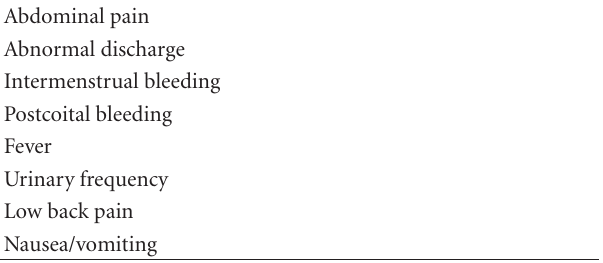
Table 1: Symptoms in women with clinically suspected pelvic inflammatory disease.